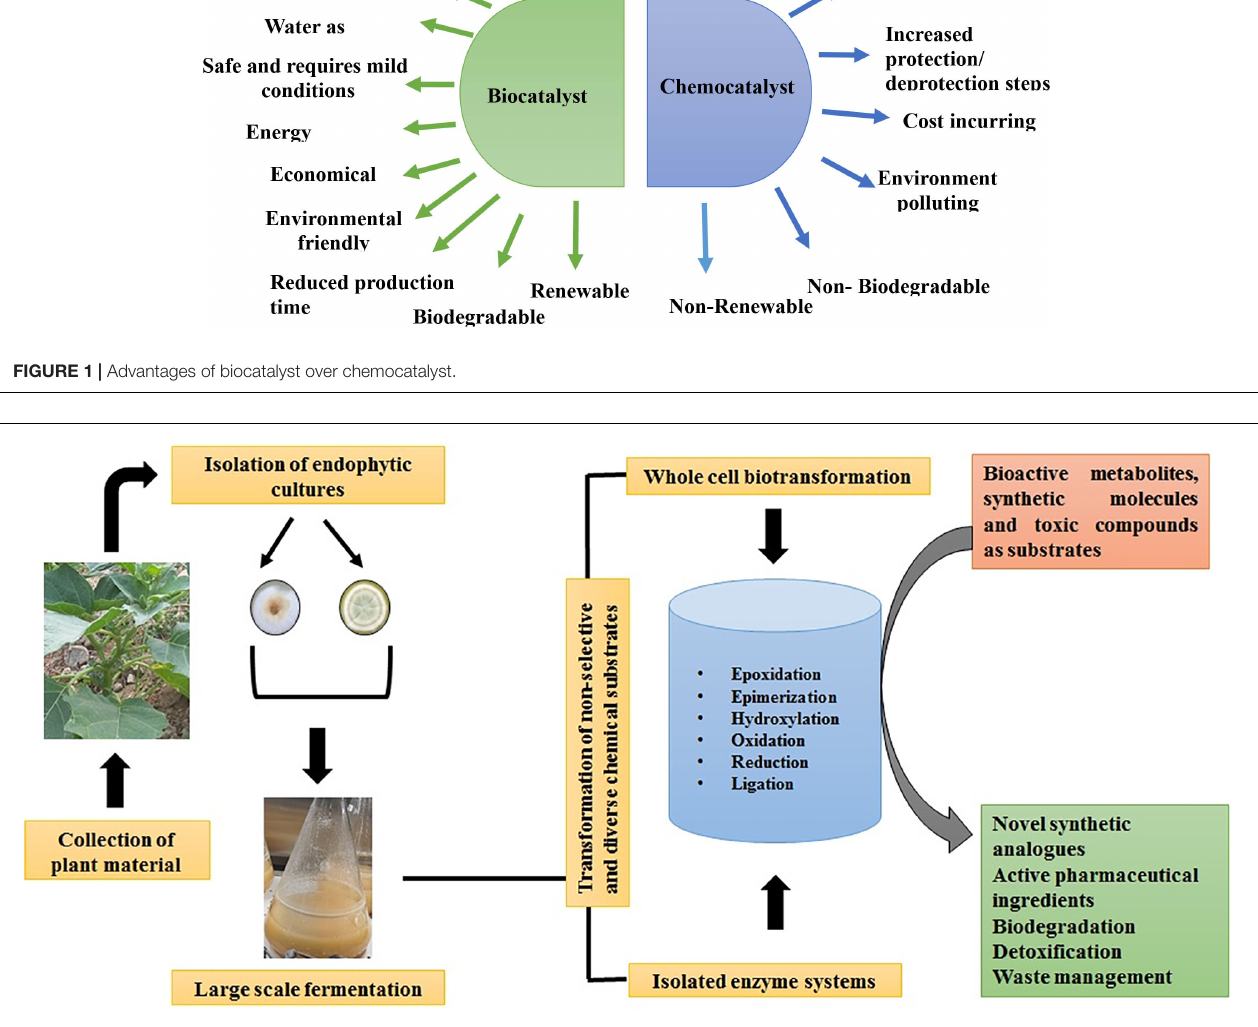
FIGURE 2 | A schematic representation of the biotransformation process mediated by fungal